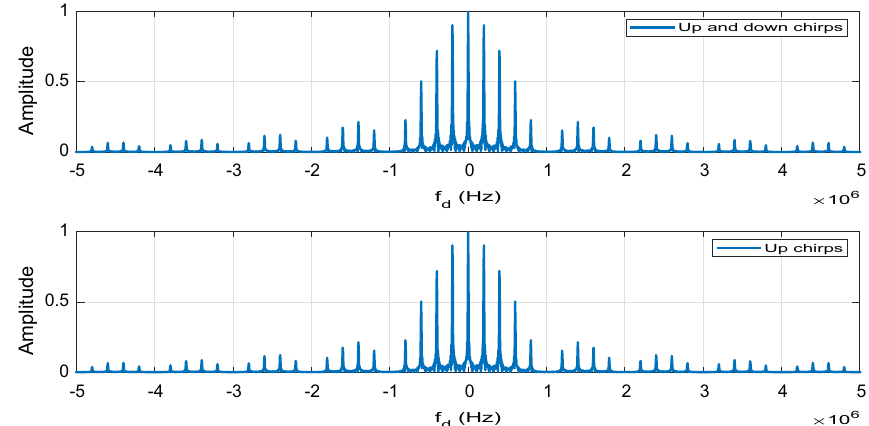
Fig. 7 Zero-delay cut of the CAF for a sequence of a-(top)) up- and down- chirps, b-(bottom)) only